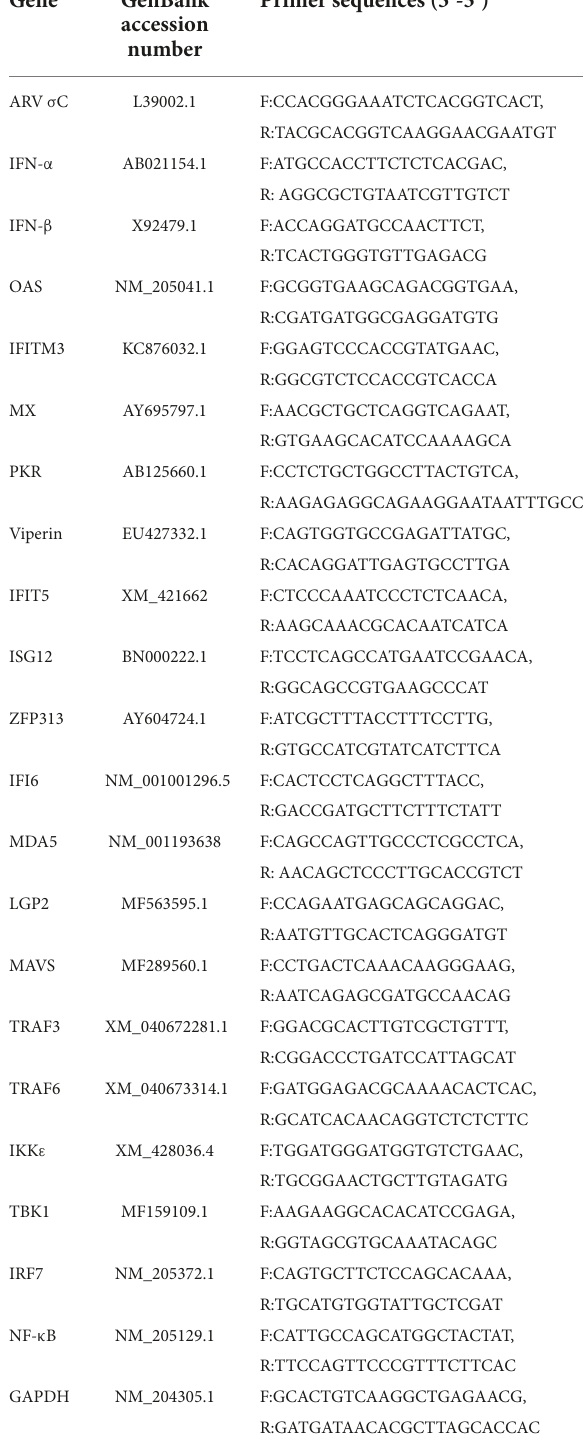
TABLE 1 Primers used in this study. Gene GenBank